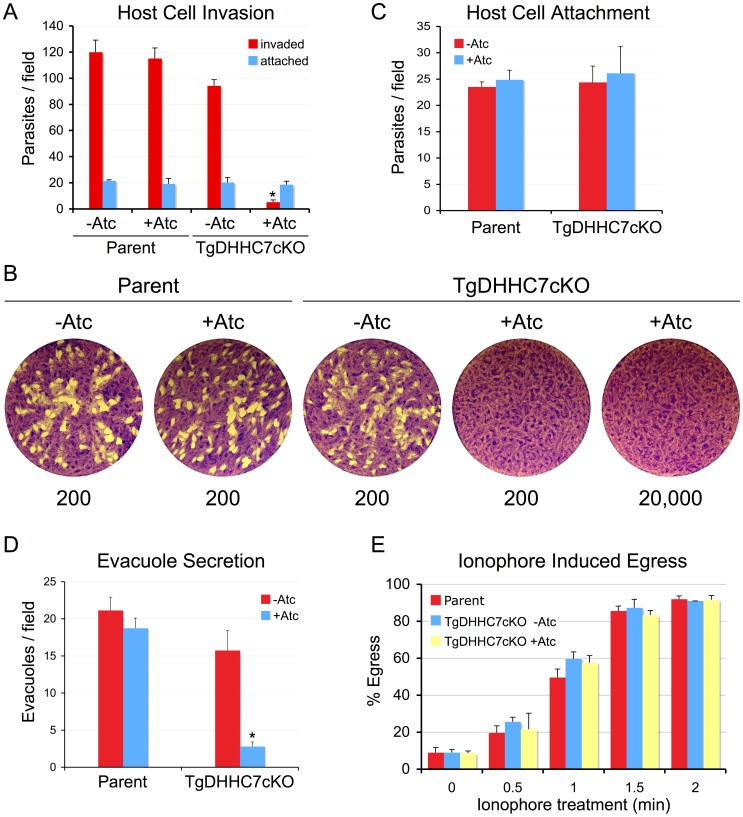
TgDHHC7 is critical for host invasion but not egress.(A–B) Parasites depleted of TgDHHC7 encounter a complete block in invasion. (A) Parental or TgDHHC7cKO parasites were grown for 72 hours−/+Atc and then allowed to invade into fresh host cells for one hour. Following depletion of TgDHHC7, parasites show a nearly complete block in host penetration (asterisk, p-value<0.001). A corresponding increase in attached, uninvaded parasites is not seen (blue bars). A minor decrease in penetration is also seen for untreated TgDHHC7cKO, likely due to the lower levels of TgDHHC7 expressed in this strain relative to the parental line. (B) Parasites depleted of TgDHHC7 cannot form plaques in fibroblast monolayers. Parental or TgDHHC7cKO parasites were grown 48 hours−/+Atc and then infected into fresh fibroblast monolayers at an infective dose of 200 parasites per well and allowed to incubate for nine days. TgDHHC7cKO parasites are unable to form plaques in the presence of Atc, even at an infective dose of 20,000 parasites per well. (C) Initial attachment is not affected upon knockdown of TgDHHC7. Parasites were grown for 60 hours−/+Atc before treatment with cytochalasin D to block motility and arrest the invasion process just after attachment. (D) Loss of TgDHHC7 impairs secretion of evacuoles by rhoptries (asterisk, p-value<0.001). Parasites were grown for 60 hours−/+Atc before treatment with cytochalasin D to block invasion and allow evacuole formation. Evacuoles were detected by staining for ROP2/3/4. (E) Parasite egress is unaffected by knockdown of TgDHHC7. Parasites were grown 60 hours−/+Atc and then induced to egress by treatment with calcium ionophore A23187 before fixation and staining for detection with anti-SAG1. The egress efficiency of parasites with defective rhoptries (lacking TgDHHC7) was not significantly different from parental or untreated TgDHHC7cKO parasites.